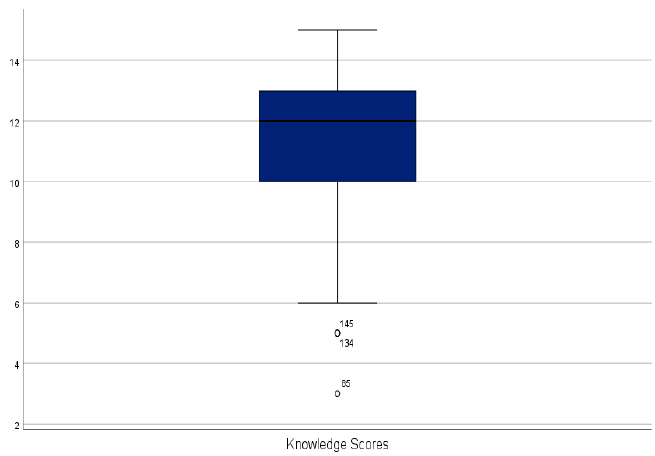
Figure 2. Box Plot of knowledge scores.